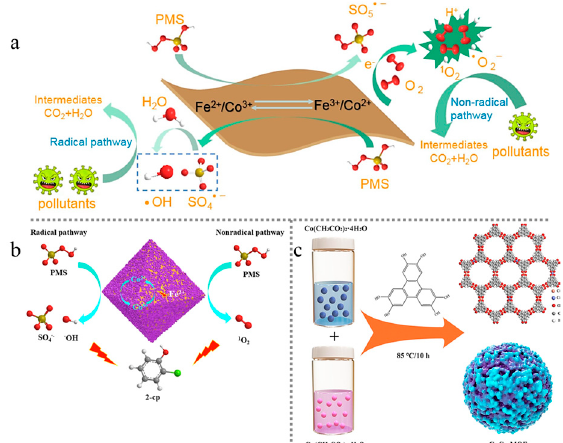
Figure 9. Schematic diagram of the reaction mechanism of ( a ) FeCo-BDC activated PMS (adapted with permission from Ref. [76], 2023, Elsevier) and ( b ) M/Z 2 activated PMS (adapted with permission from Ref. [77], 2023, Elsevier). ( c ) Schematic diagram of CuCo-MOF synthesis process. Adapted with permission from Ref. [78], 2023, Elsevier.